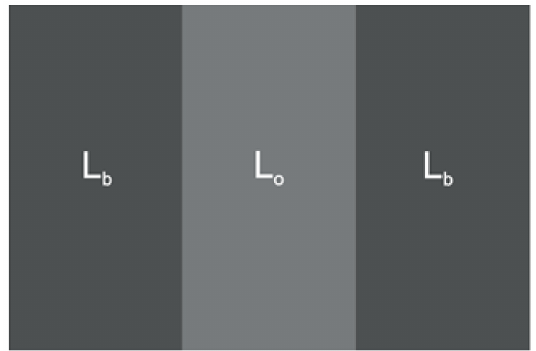
Figure 12. Areas taken into account for measuring luminance contrast, L b —background luminance, L o —object luminance.